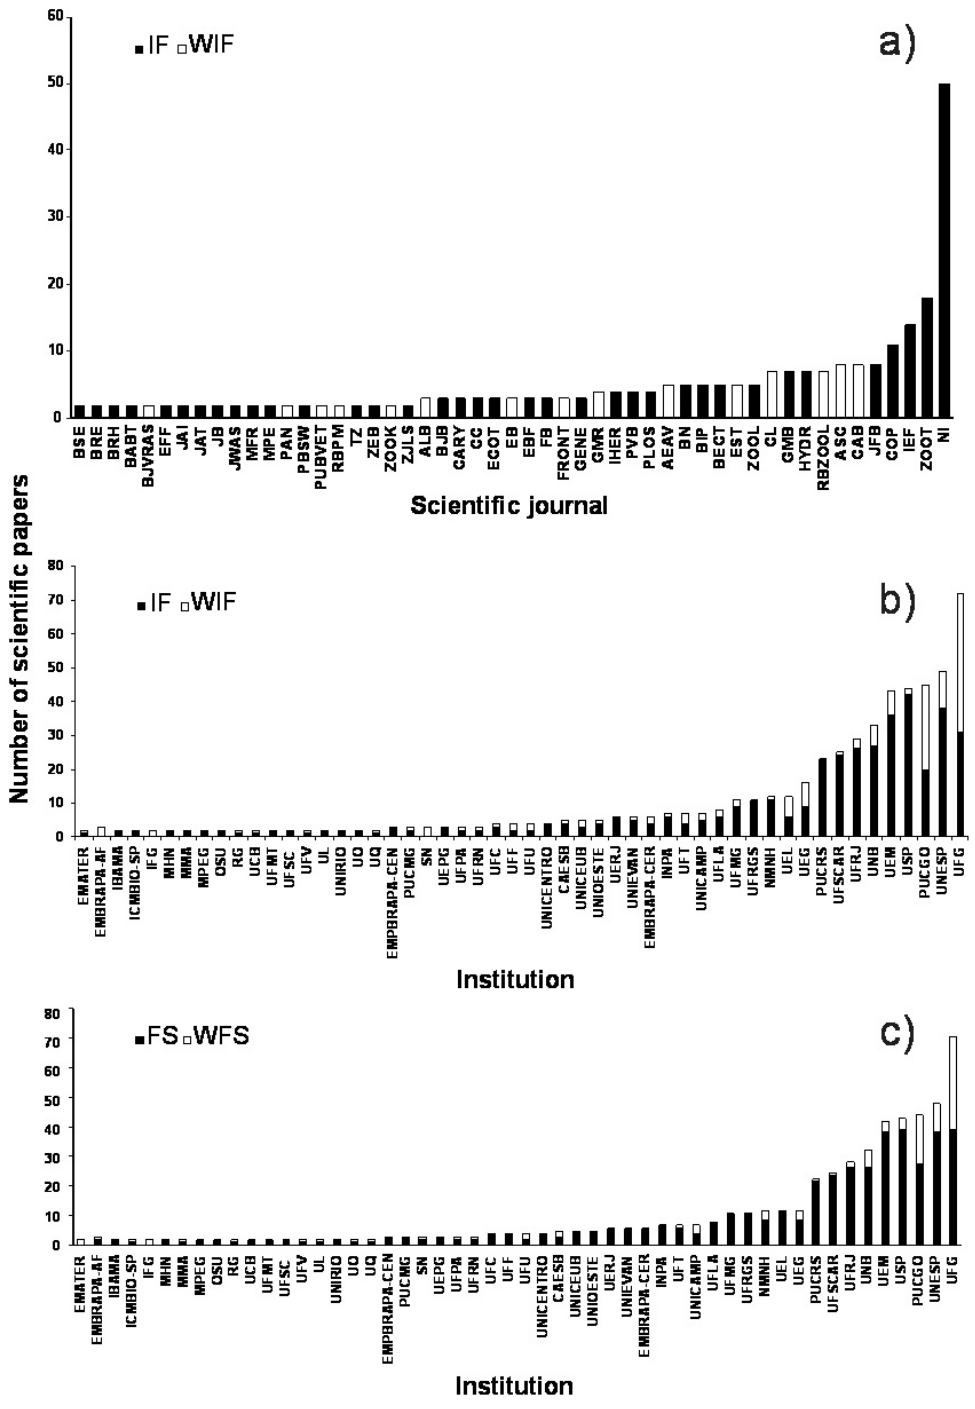
Figure 4. Number of scientific papers published per journal (a), institution and impact factor (b), and institution and financial support (c). IF= with impact factor; WIF=without impact factor; FS=with financial support; WFS=without financial support. The full name of each journal is provided in Table